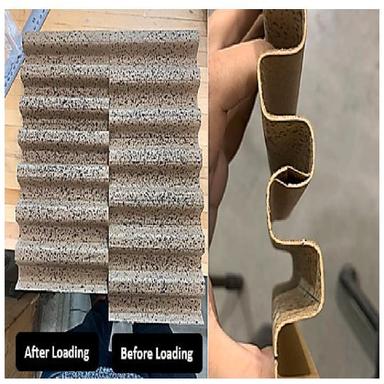
1904 panels before and after transverse compression loading and delamination failures of these panels.